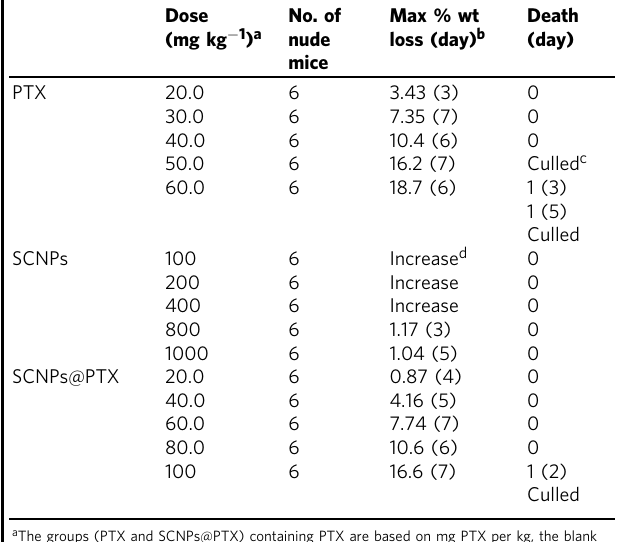
Table 2 Treatment response for MTD